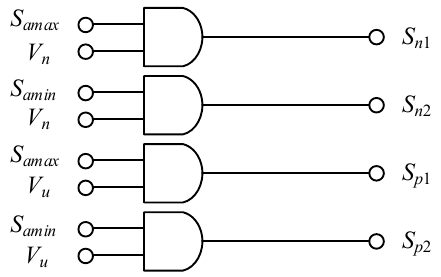
Figure 3. The re-coupling logic of the A phase drive signal.